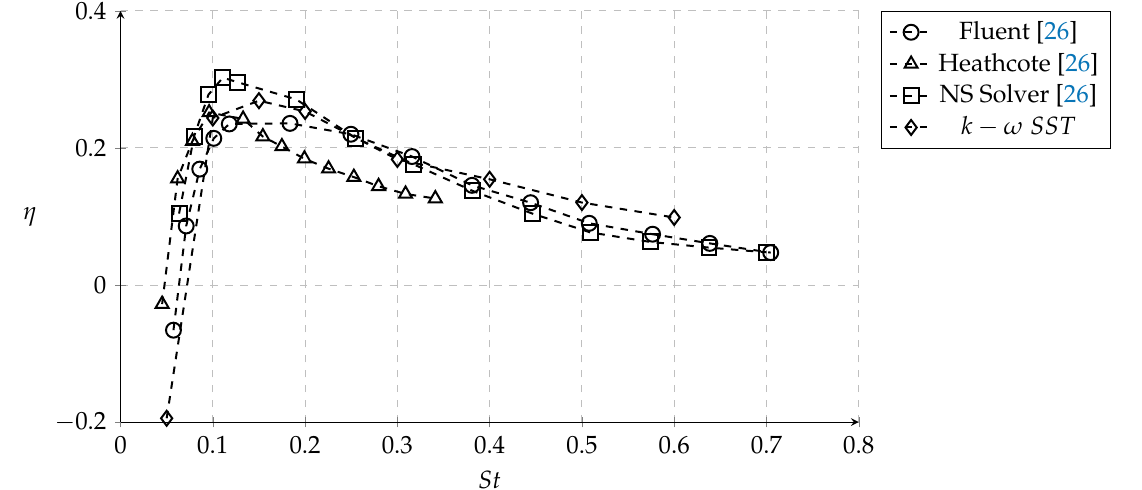
Figure 4. Propulsive efficiency as a function of the Strouhal